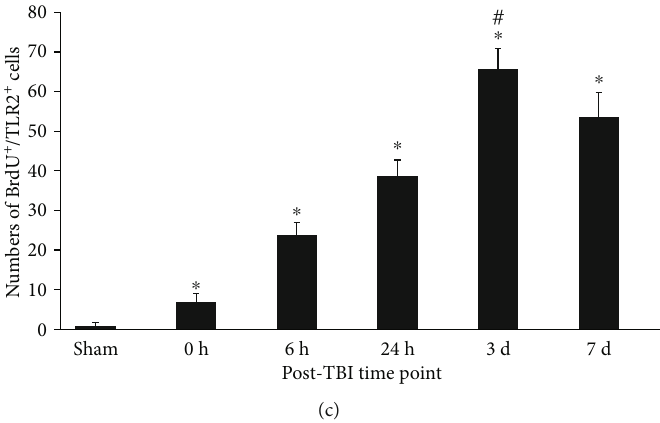
Figure 2: Immuno fl uorescence (IF) microphotographs in the dentate gyrus (DG) of the DG in sham and TBI groups at di ff erent time points. (a) BrdU-labelled NSCs (red fl uor), expression of TLR2 (green fl uor), cell nuclei (blue fl uor), and BrdU + /TLR2 + /DAPI + cells indicated that TLR2 expression in labelled proliferating cells was possible NSCs; (b) BrdU + cells showed the proliferation of NSCs in the DG during di ff erent time points posttrauma. BrdU + cells were more in the TBI group than that in the sham group ( ∗ p < 0 : 05 ), and numbers of these cells were signi fi cantly di ff erent among di ff erent time points posttrauma ( # p < 0 : 05 ); (c) numbers of BrdU + /TLR2 + cells indicated that the expression of TLR2 was quite di ff erent in proliferating cells of the DG among di ff erent time points posttrauma. There were more BrdU + cells in the TBI group than that in the sham group ( ∗ p < 0 : 05 ), and the numbers of these cells are obviously di ff erent among di ff erent time points posttrauma ( # p < 0 : 05 ). Scale bar: 50 μ m; data is shown as mean ± SEM